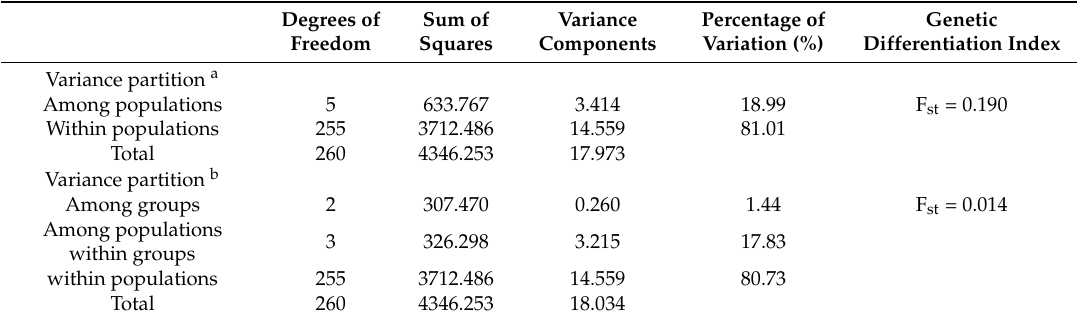
Table 5. Analyses of molecular variance (AMOVA) for different populations and groups of A. miaotaiense